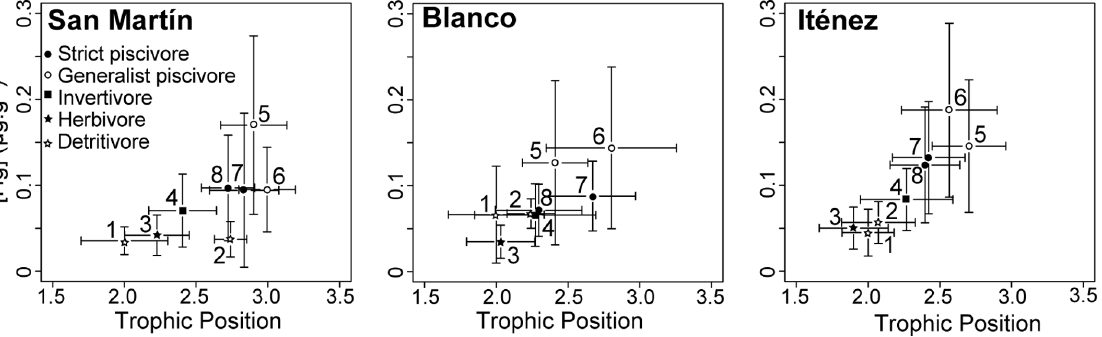
Figure 3. Mercury biomagnification in fish assemblage of three rivers from the Ite´nez basin (Amazon, Bolivia). Biplots display mean values ( 6 sd in error bars) of Trophic Position (derived from d 15 N) and [Hg] ww of detritivore (1=Curimatella cf. alburna, 2=Psectrogaster sp.), herbivore (3=Schizodon fasciatus) , insectivore (4=Triportheus angulatus) and piscivore (5= Pseudoplatystoma sp., 6= Pygocentrus nattereri, 7= Hoplias malabaricus and 8=Acestrorhynchus sp.) fish species. Slope of the relation correspond to biomagnification along the food chain. doi:10.1371/journal.pone.0065054.g003 PLOS ONE |